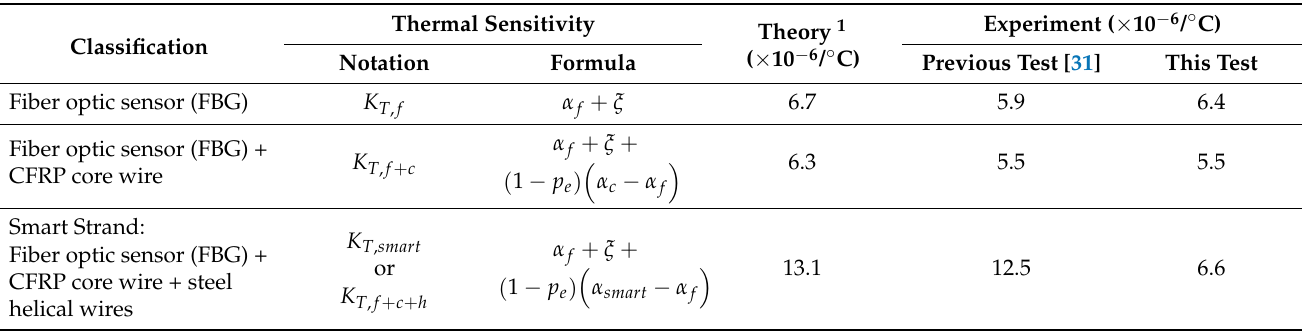
Table 2. Comparison of various theoretical and experimental values of thermal